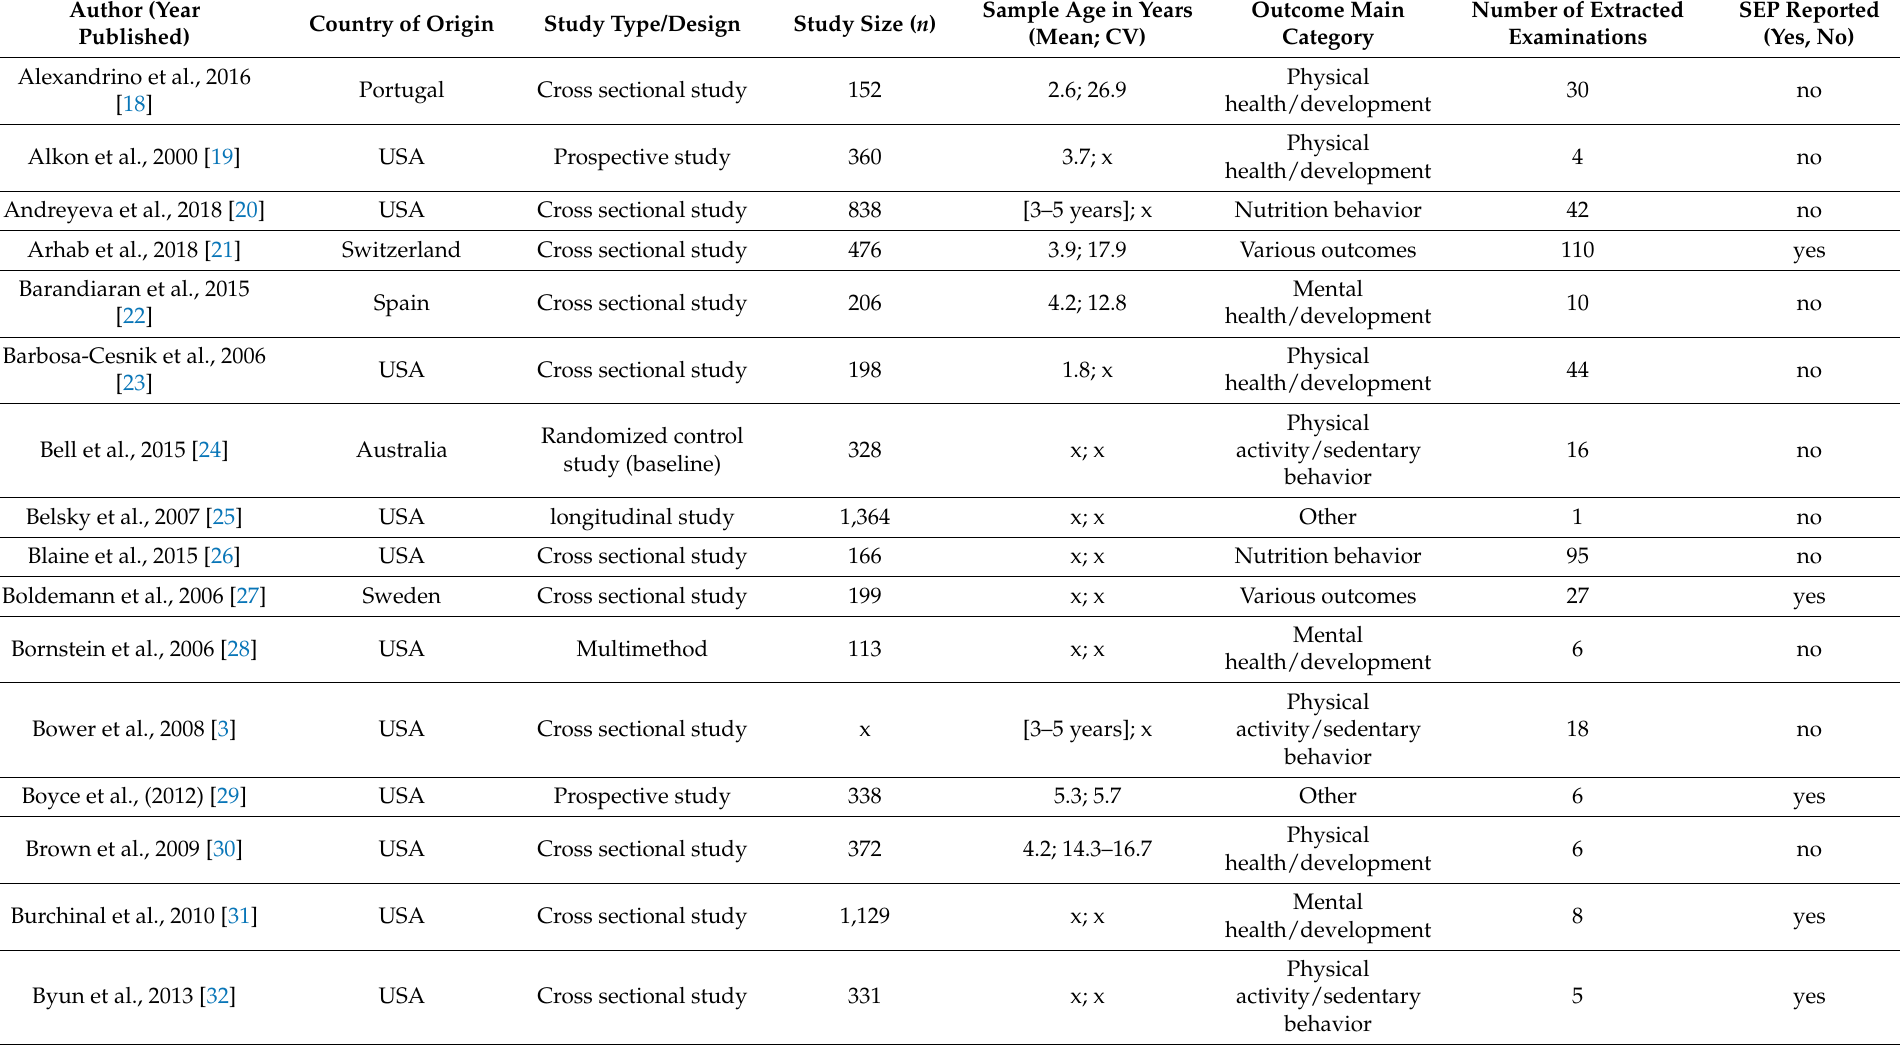
Table 1. Overview over included